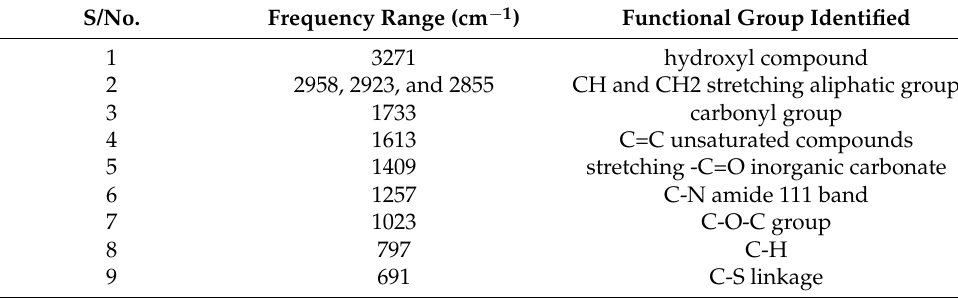
Table 2. FTIR and the functional groups present in MoP.